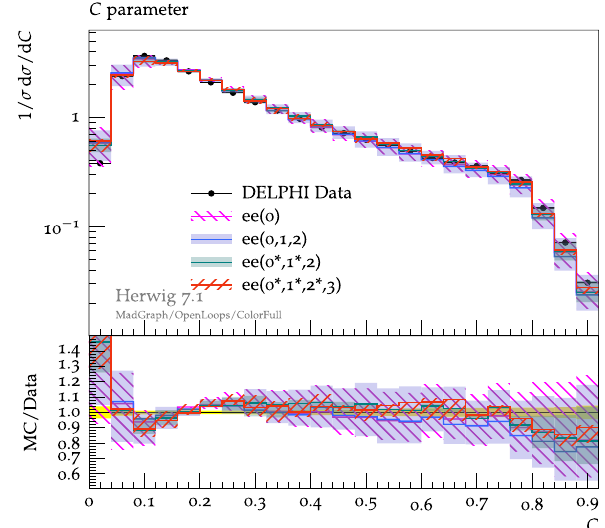
Fig. 18 Data [63] comparison to the C -parameter which is sensitive to the first emission. NLO corrections to the first and second emission reduce the scale